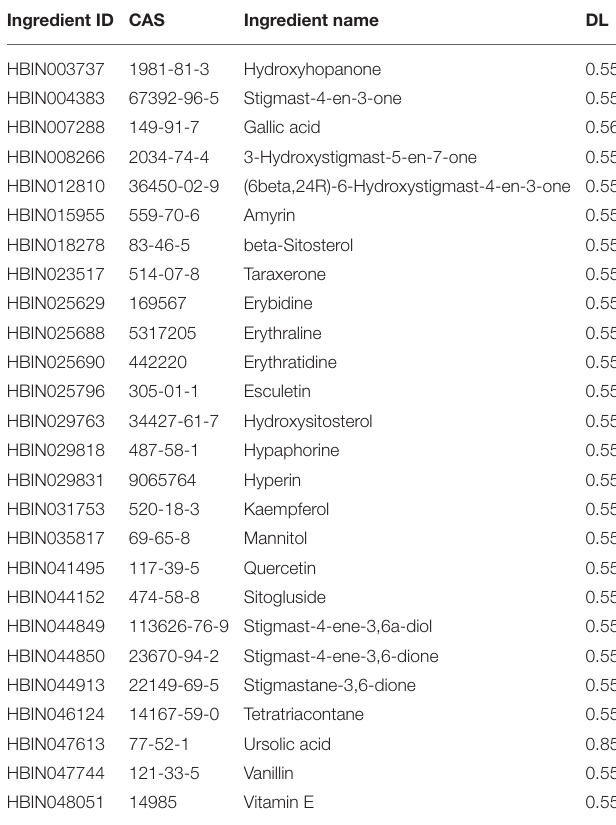
TABLE 2 | Information of bioactive components of